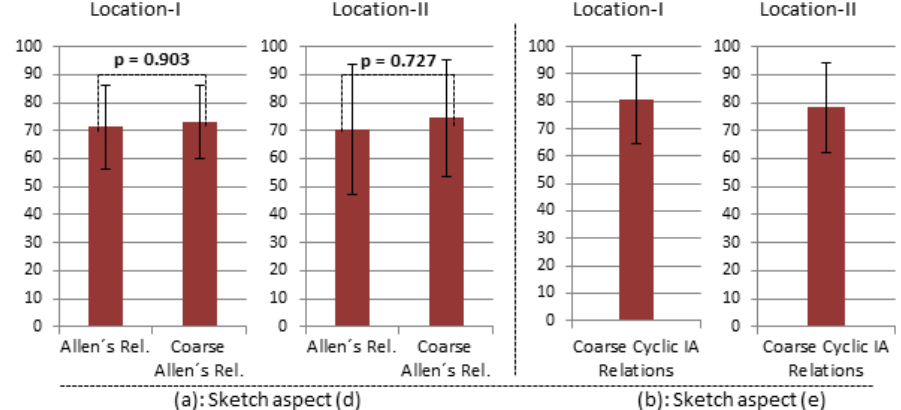
Figure 9: (a) The accuracy rates with insignificant differences ( p -values) in the matching results using the IA and coarse IA relations (b) the accuracy of qualitatively matched land- marks using the coarse CIA